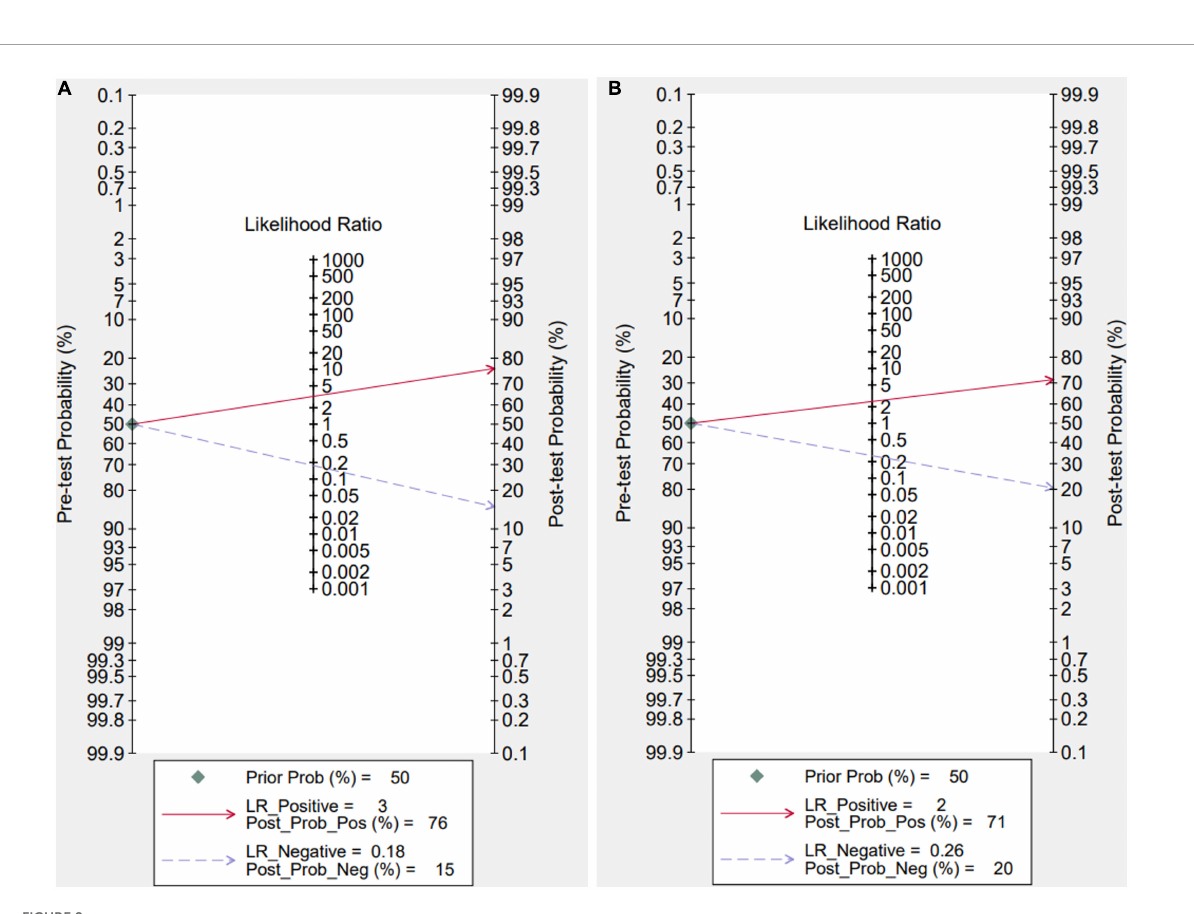
FIGURE8 Fagan nomogram for interleukin 35 (IL-35) in sepsis diagnosis (A) , IL-35 (B) , procalcitonin